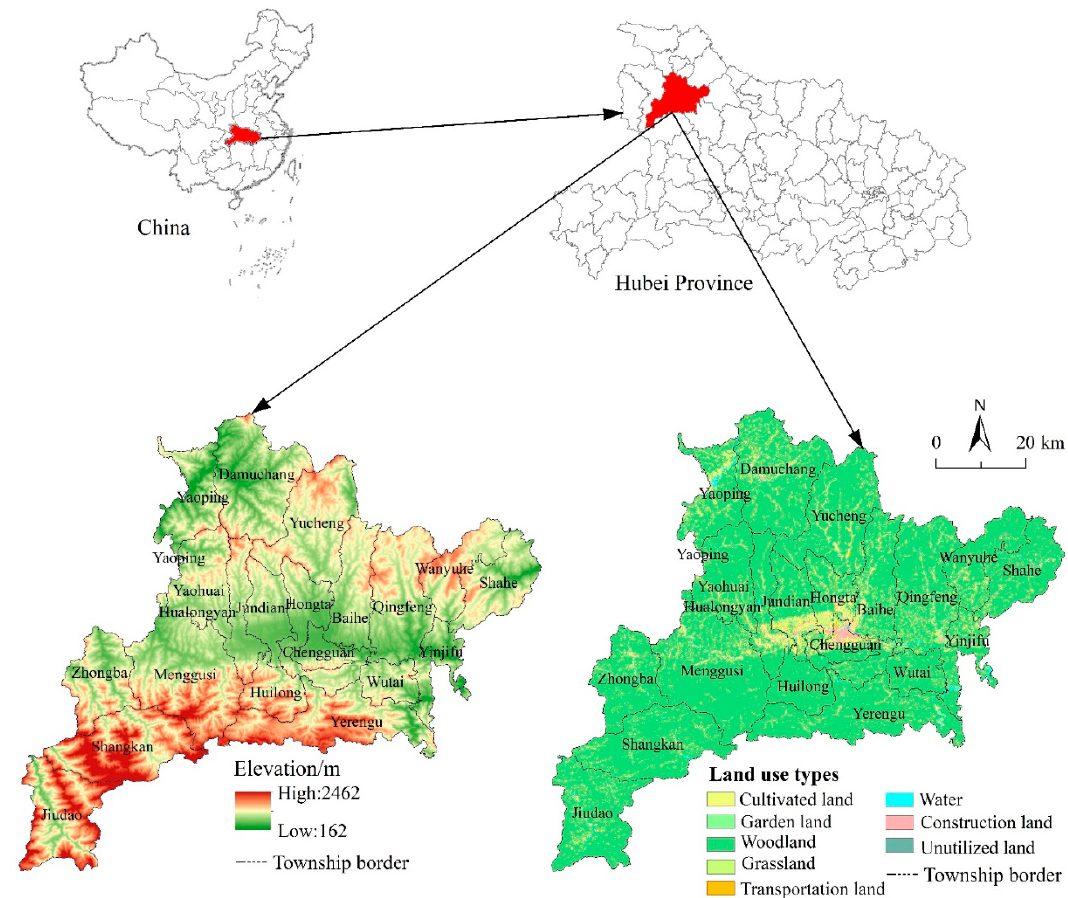
Figure 1. Location, elevation, and distribution of land-use types of Fang County in 2017.